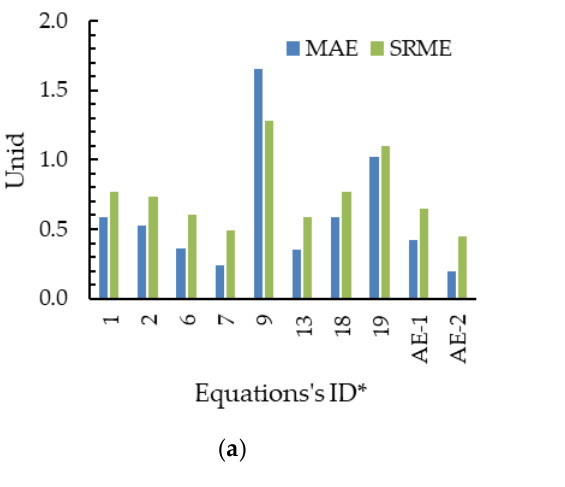
Figure 11. Graphs with the main error analyses for the HHV predictions from equations based on ultimate analysis: ( a ) mean absolute error (MAE) and square root mean error (RSME); ( b ) mean absolute percentage error (MAPE). * ID: equation identification.